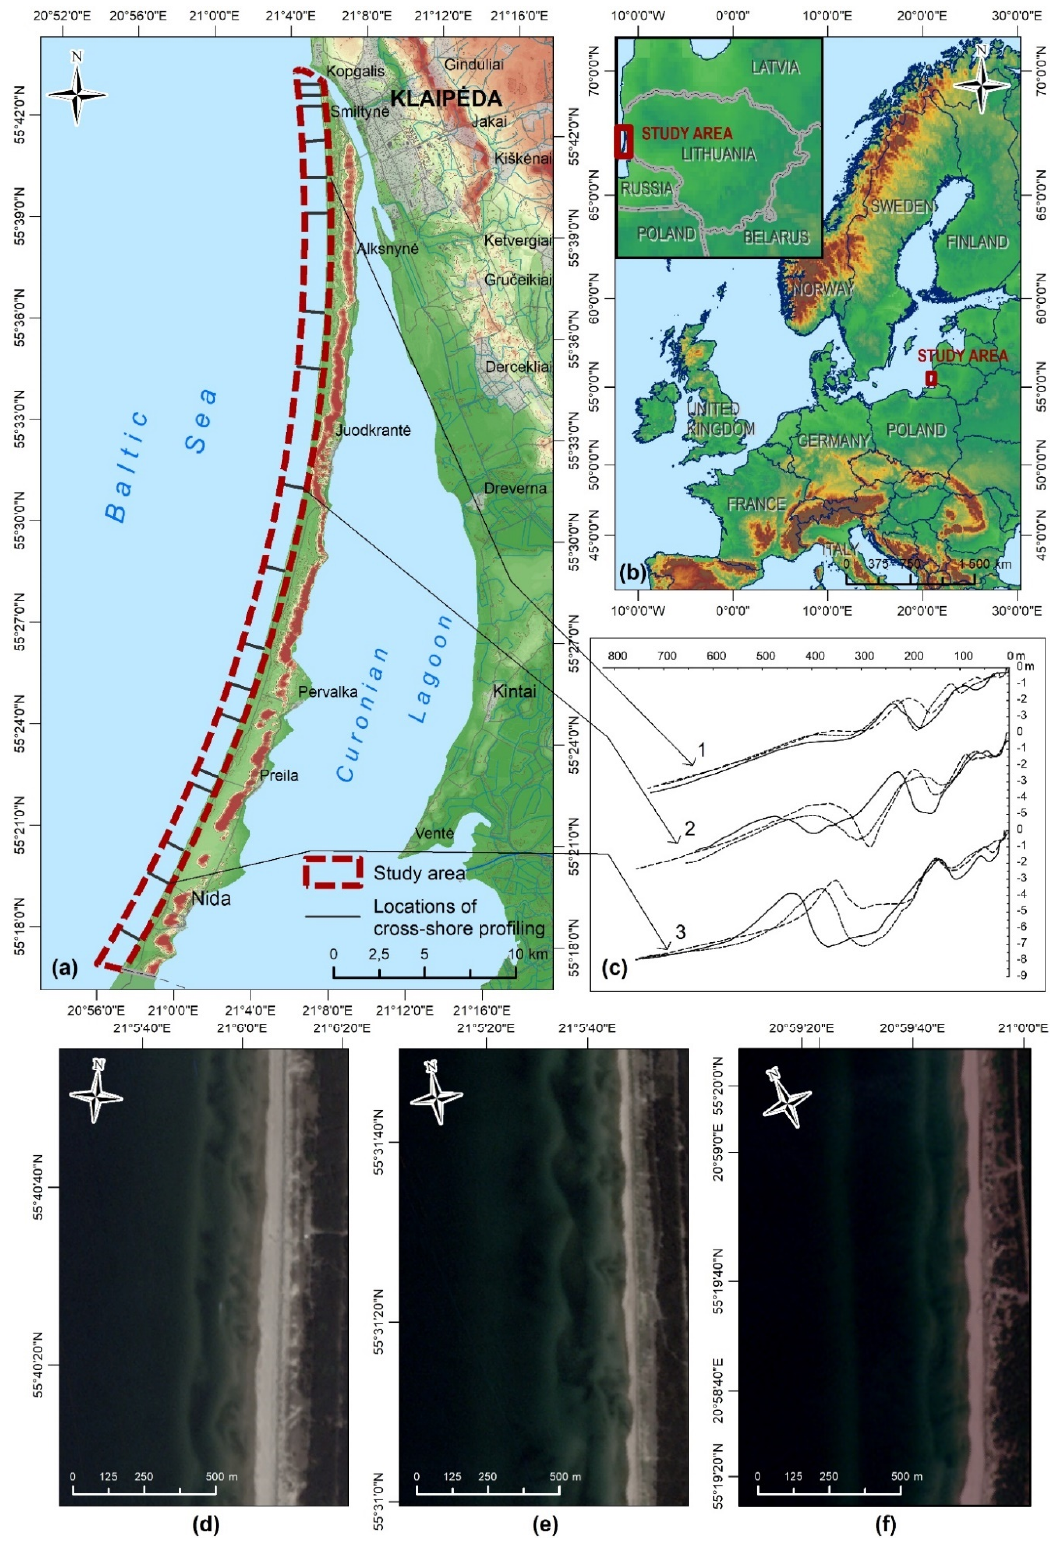
Figure 1. Study area: ( a ) a configuration of the study area and locations of nearshore cross-shore profiling used for algorithm validation; ( b ) the situation of the study area; ( c ) examples of nearshore cross-shore profiles at three different locations in the Curonian Spit; ( d , e ) examples of PlanetScope and RapidEye ( f ) imagery at the same locations as examples of cross-shore profiles (profile 1 corresponds to ( d ); 2–( e ), 3–( f